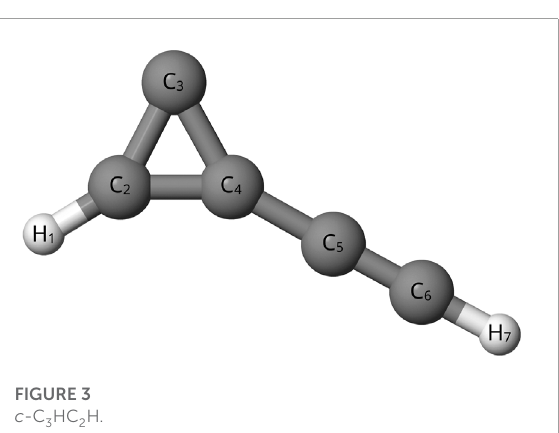
FIGURE 3 c -C 3 HC 2